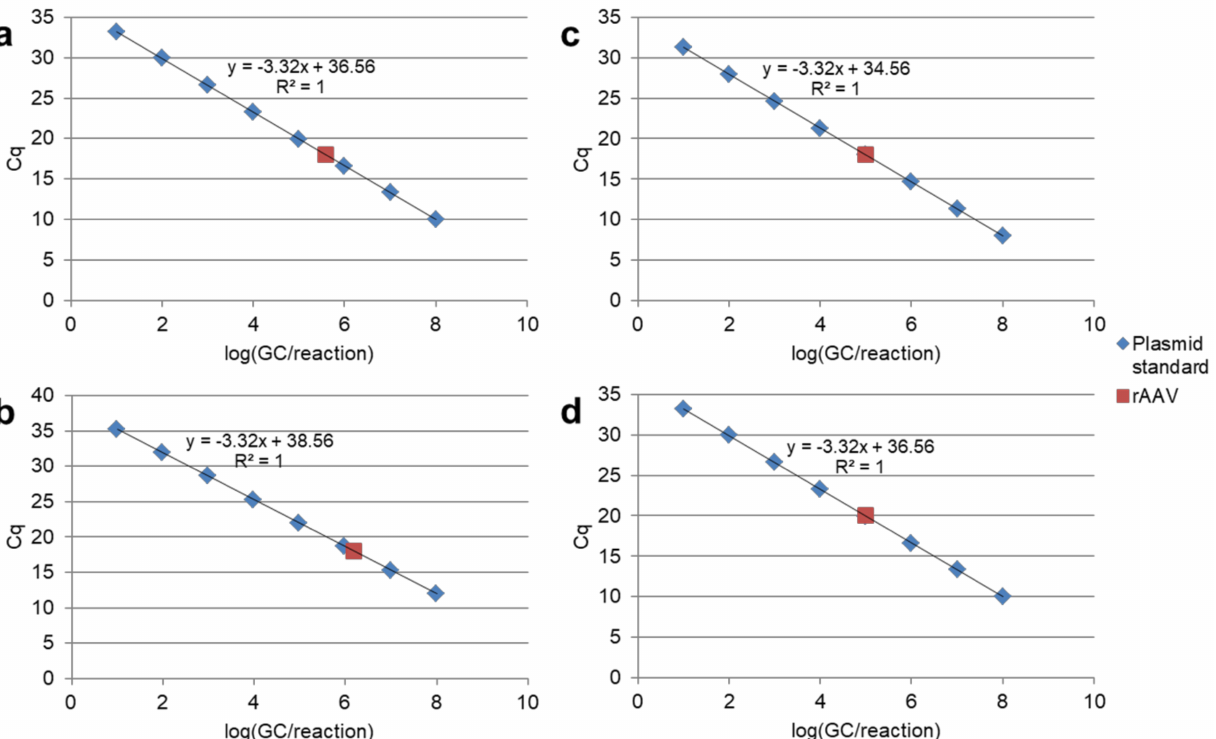
Figure 2. Modeling of incorrect rAAV sample titer estimation due to differences in calibration stan- dard and rAAV sample amplification efficiency. ( a ) Both plasmid calibration standard and rAAV amplify efficiently with real sample titer estimation. ( b ) Plasmid calibration standard is underesti- mated and rAAV amplifies normally. This leads to sample titer overestimation. ( c ) Plasmid calibration standard overestimated and rAAV amplifies normally. This leads to sample titer underestimation. ( d ) Plasmid calibration standard amplifies normally and rAAV